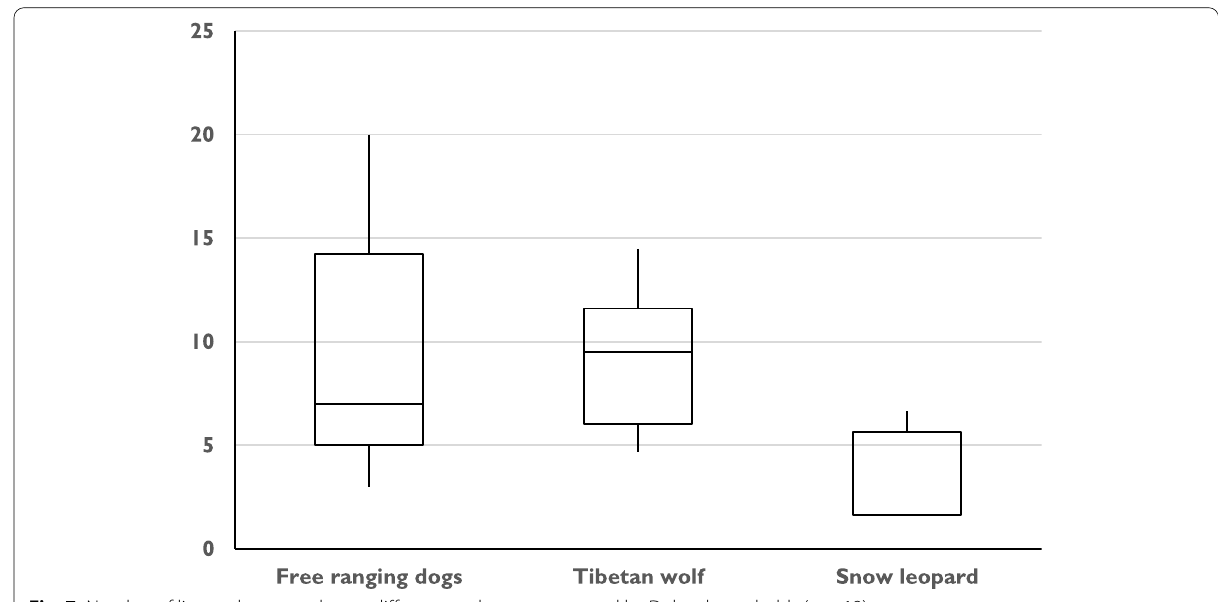
Fig. 7 Number of livestock per year lost to different predators, as reported by Dokpa households ( n